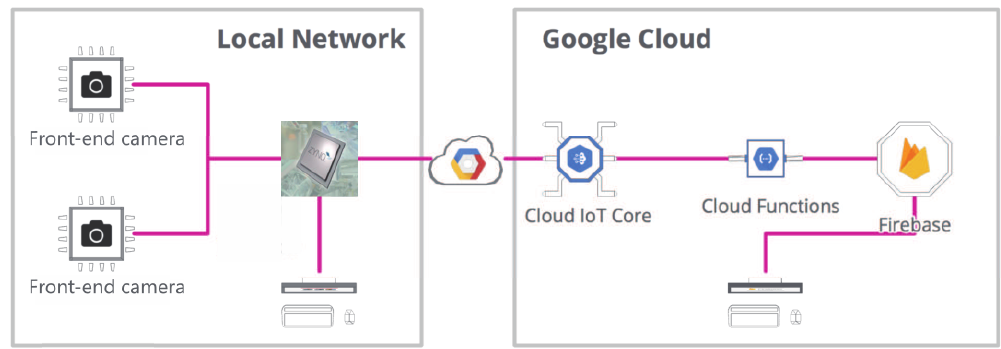
Figure 1. The system design of our tracking system in IoT and edge computing